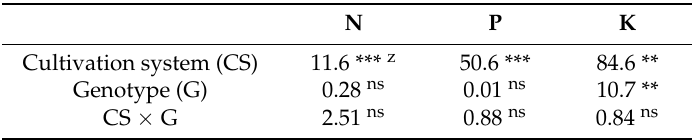
Table 3. F -values from a two-way analysis of variance (ANOVA) of leaf nitrogen, phosphorus, and potassium content as affected by three cultivation systems and two